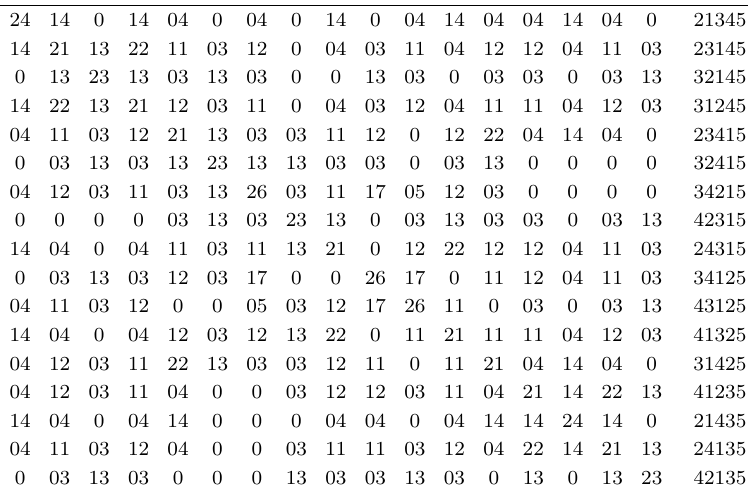
Table 3 . Representation of the TMD-valued color matrix and vector of partial amplitudes for the processes g (cid:3) g 2 ! g 3 (cid:22) q 4 q 5 . Each pair ij of intergers represents N i 1 the entry vanishes. The last column gives the permutation associated with the partial amplitudes.